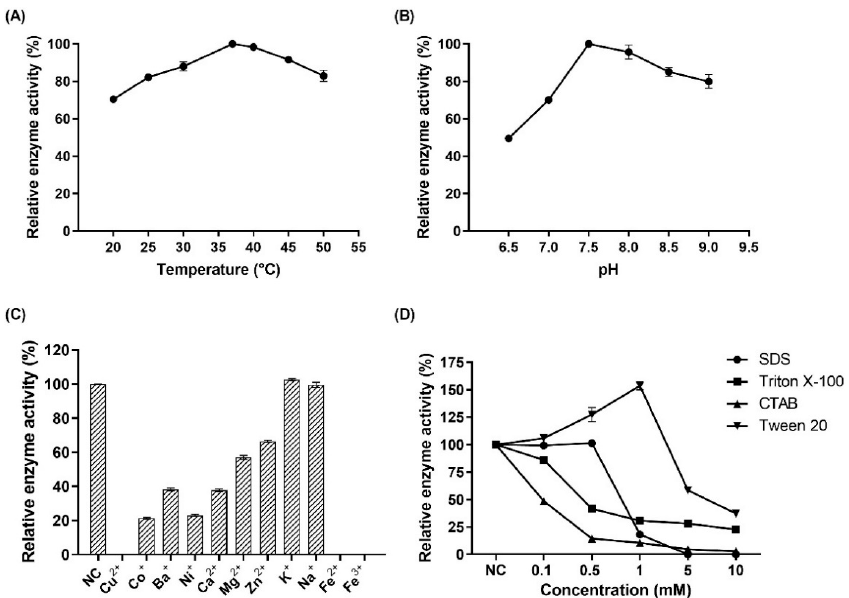
Figure 7. Effect of temperature ( A ), pH ( B ), metal ions ( C ), and surfactants ( D ) on enzyme activity of MBP-PAI.